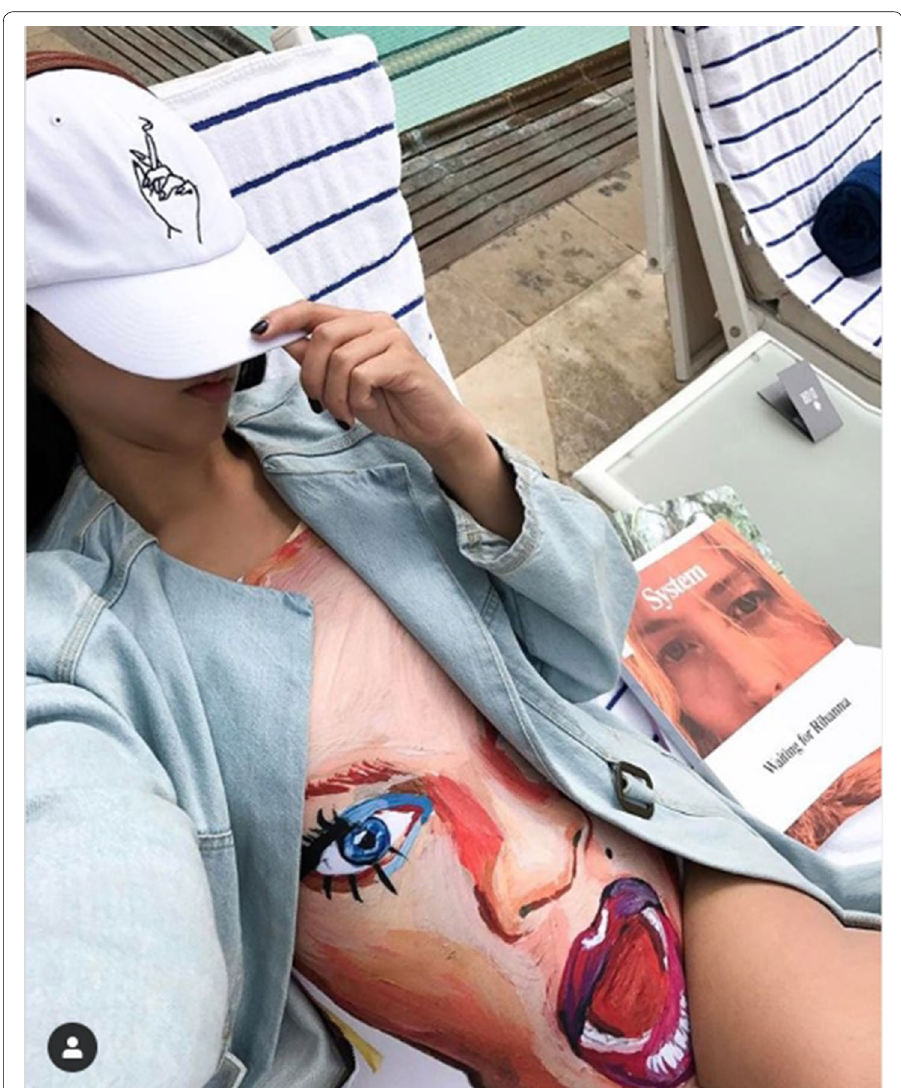
Fig. 2 15 min of poolside. https ://www.insta gram.com/p/BUAIR y7FD2 6/. Accessed 5 September